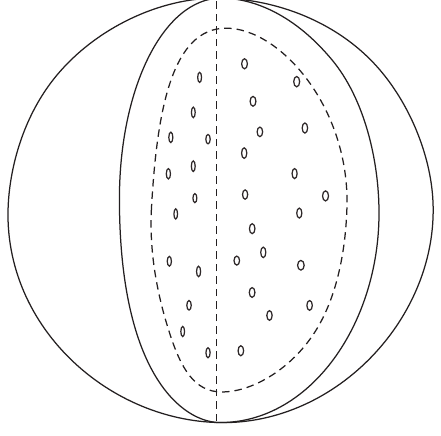
Figure 1: Scheme of a pebble.